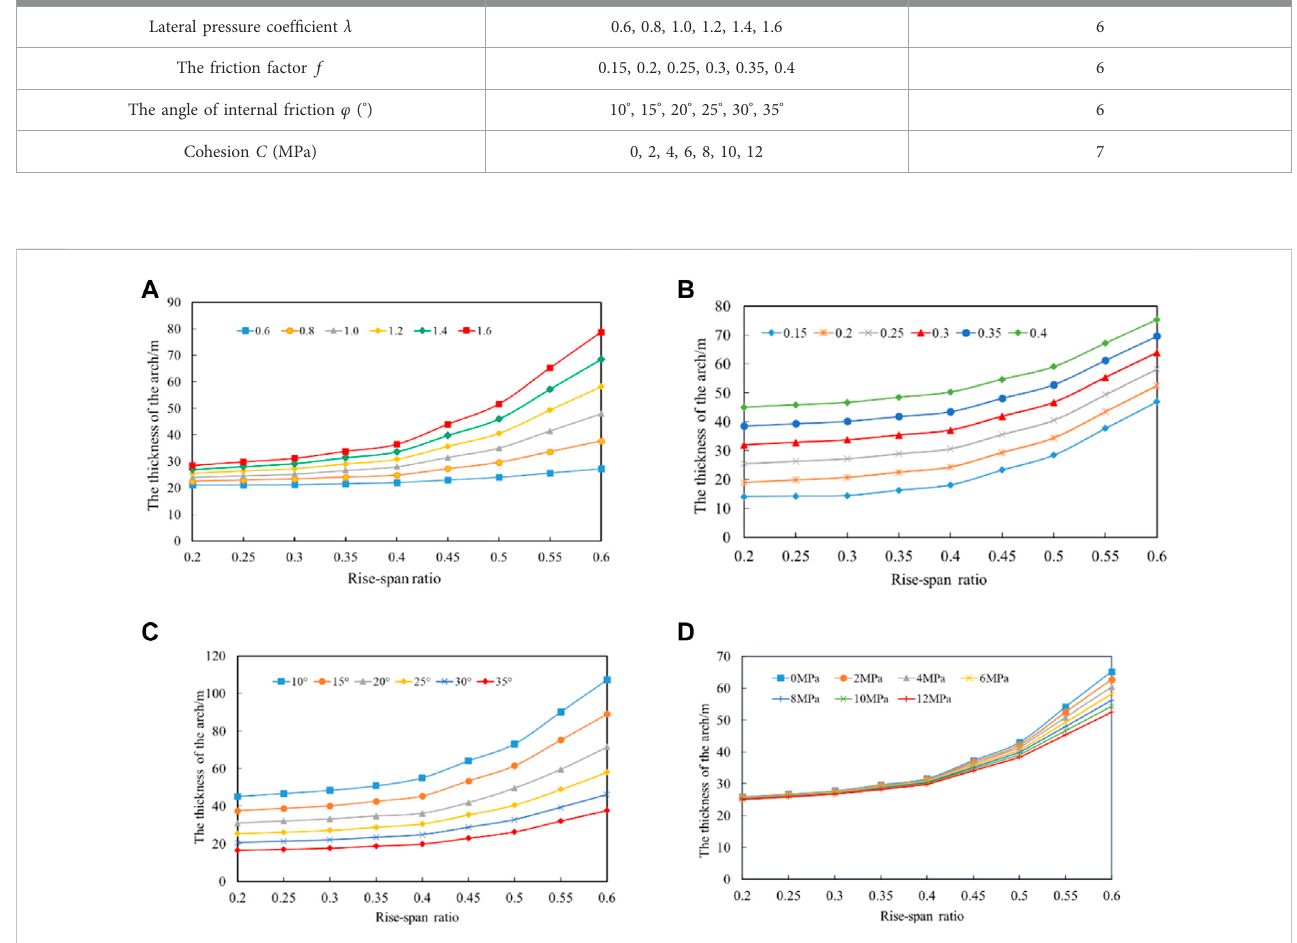
Frontiers in Earth